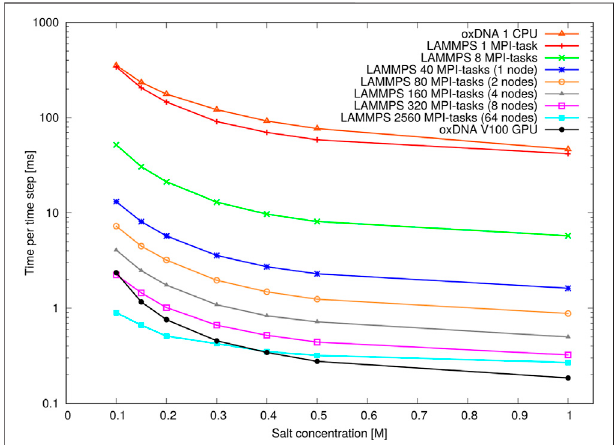
FIGURE 13 | Performance of the pointer benchmark as time per time step at various salt concentrations: Shown are results of the oxDNA standalone code ona single CPU and NVIDIA V100 GPU and ofthe LAMMPS implementation of the oxDNA2.0 model at different core